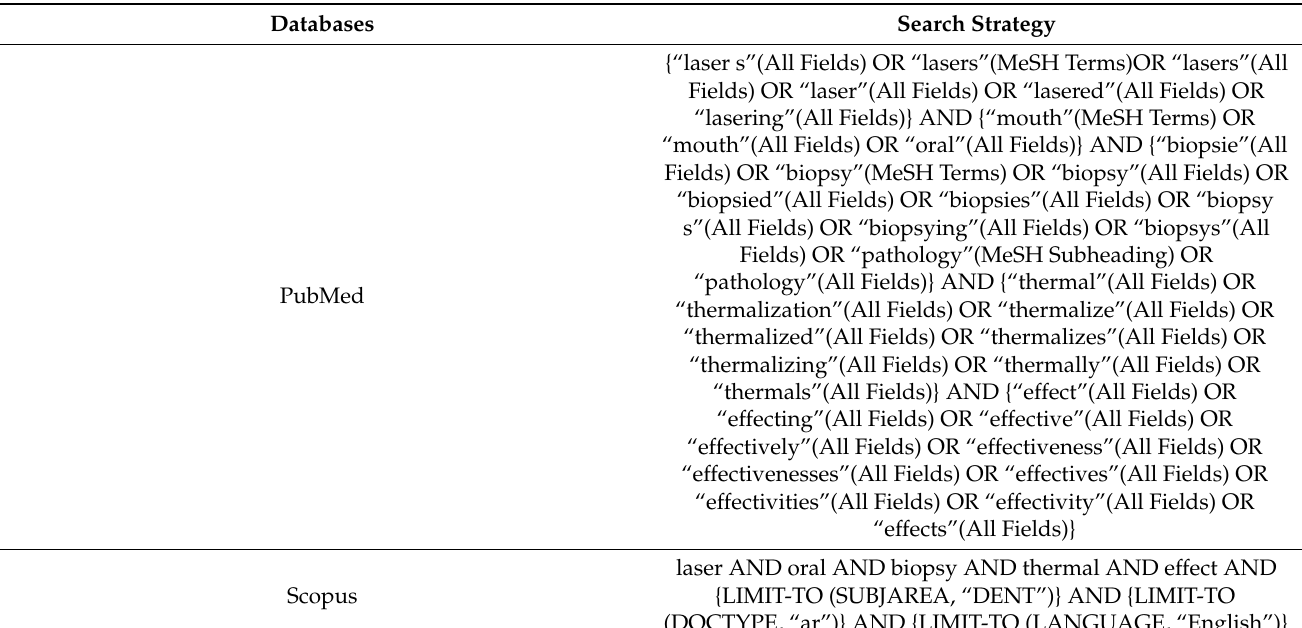
Table 1. Shows the used search strategy in the PubMed and Scopus databases.